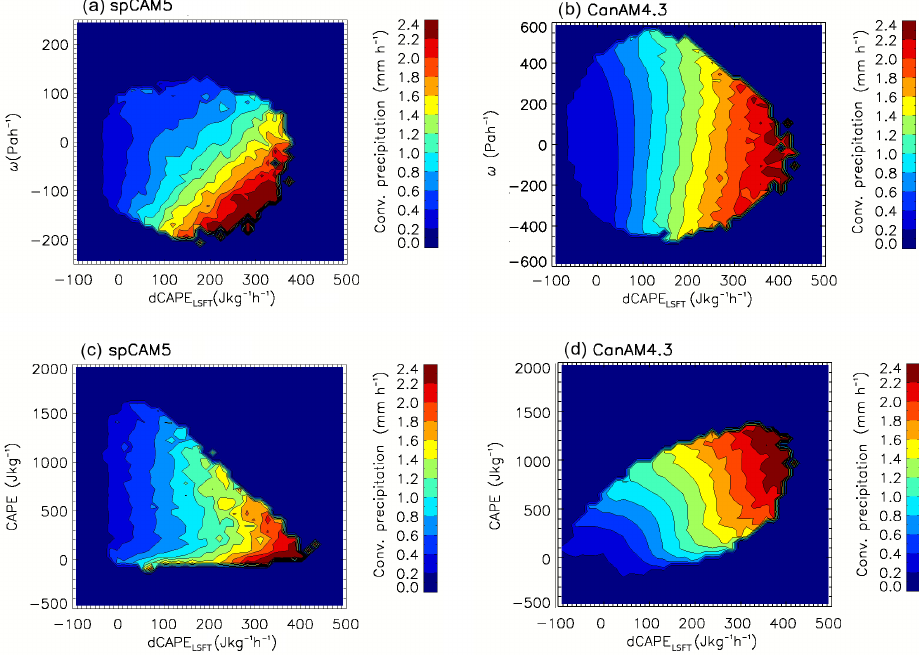
Figure 3. (a) spCAM5 and (b) CanAM4.3 mean convective precipitation as function of near-surface ω and dCAPE LSFT . (c) spCAM5 and (d) CanAM4.3 mean convective precipitation as function of CAPE and dCAPE LSFT . Each of the plots consists of 1600 bins, 40 on x axis and 40 on y axis. The convective precipitation within each bin is an average of at least 20